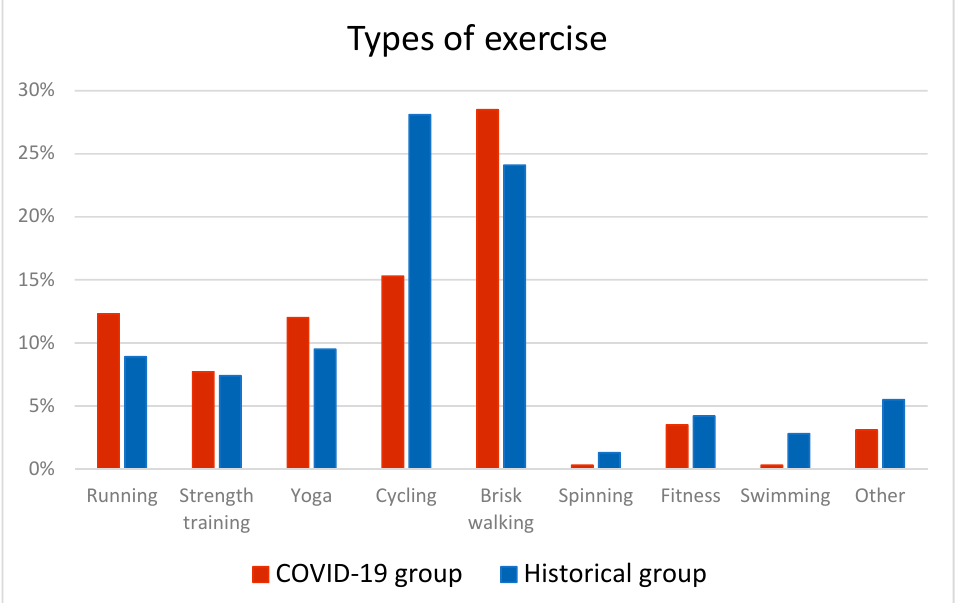
Figure 2. The distribution of types of exercise in the COVID ‐ 19 group and in the Historical group. Differences across groups were significant for cycling (FDR < 0.0001) and swimming (FDR = 0.0002) after correction for multiple testing.